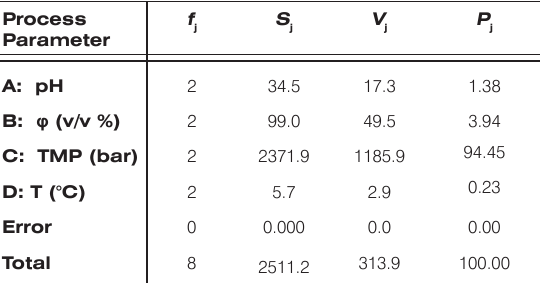
Table 6. Final results of variance analysis (ANOVA) – OA L